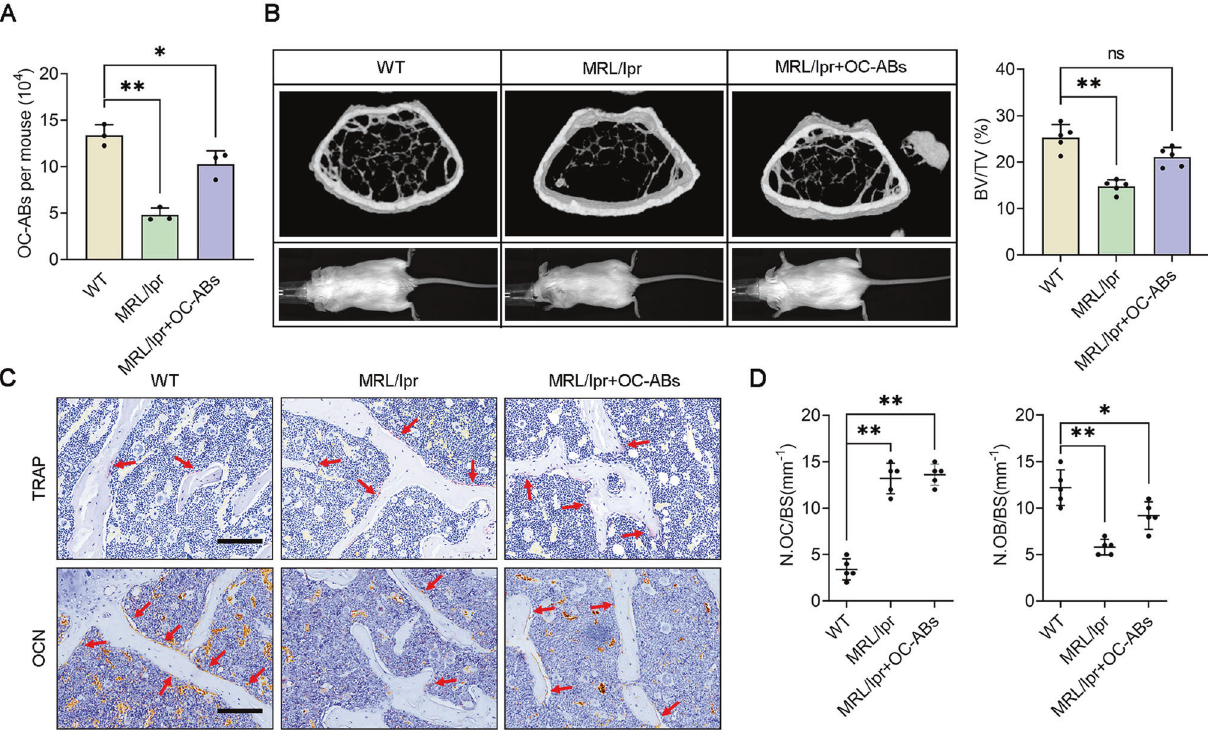
Fig. 5 Loss of OC-AB numbers directly alters bone volume fraction in vivo. A Quanti fi cation of OC-ABs from femoral bone marrow in each indicated mice, n = 3. B Representative micro-CT images and body size pictures of mice in each group. Quanti fi cation of bone volume fraction from indicated mice femoral. C Representative TRAP staining images and OCN immunohistochemical images of tibia from the indicated group of mice, scare bar = 100 μ m. D Quanti fi cation of osteoblasts (N.OB/BS) and osteoclasts (N.OC/BS) on bone surface, n = 5. One-way ANOVA analysis was used to compare multiple sets of data, * p < 0.05, ** p < 0.01, ns non-signi fi